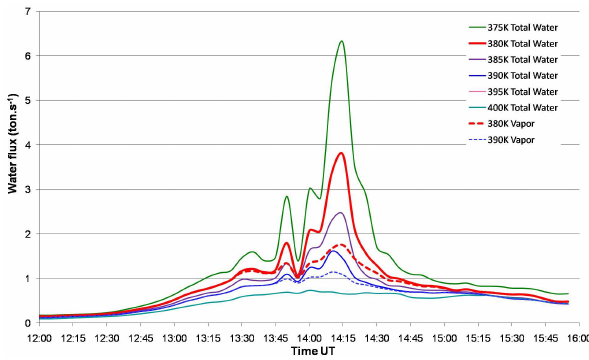
Fig. 14. Fig. 14. Upward total water flux across different isentropic levels within the BRAMS Grid 3 domain between 12:00UT and 15:55UT for the Chad case. For the 380K and 390K isentropic levels, the water vapour flux are also shown (dashed